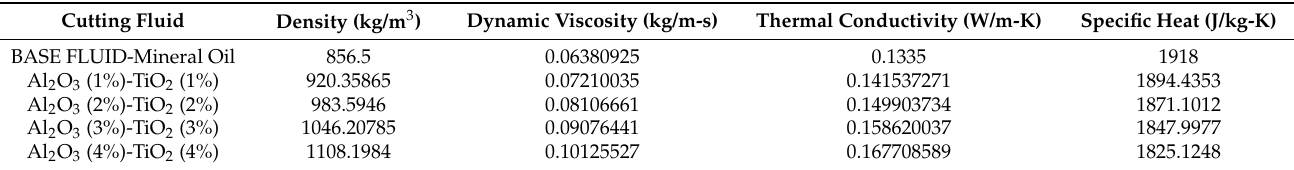
Table 2. Thermophysical and mechanical properties of mineral oil dispersed with Al 2 O 3 -TiO 2 . Cutting